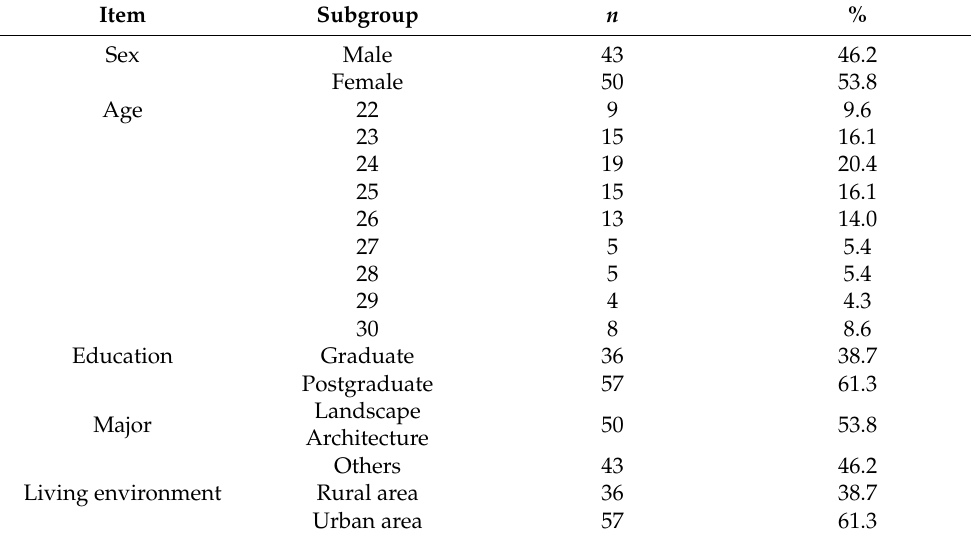
Table 4. Profile of participant attributes.